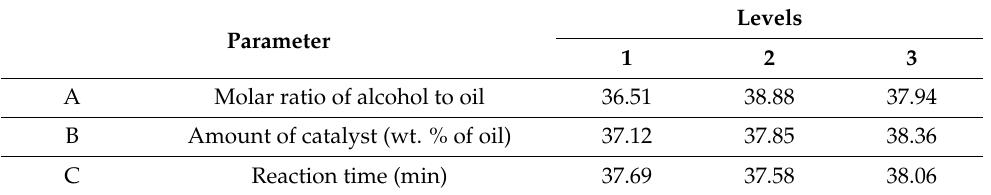
Table 6. Level mean SNR (SNR L ) for different parameter